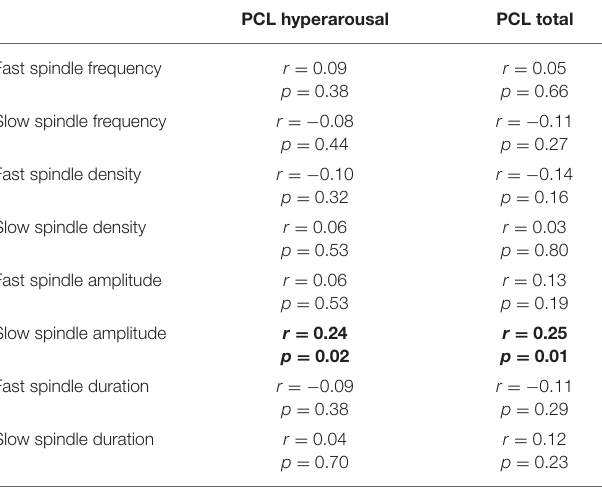
TABLE 2 | Correlations between sleep spindle properties and symptomatology. PCL